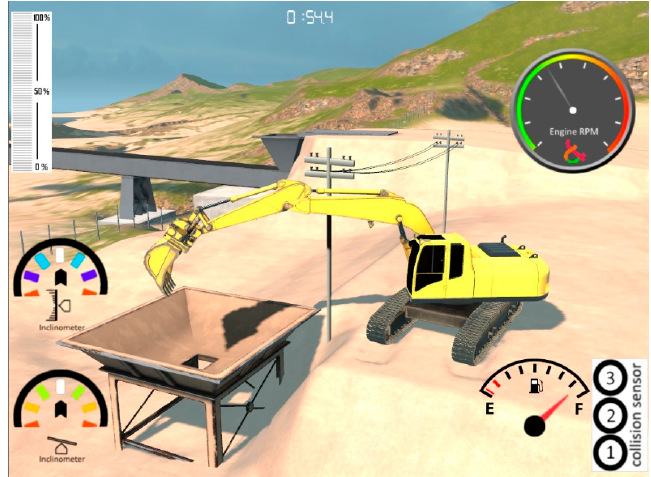
Figure 12. Environment for test and validation of the model.